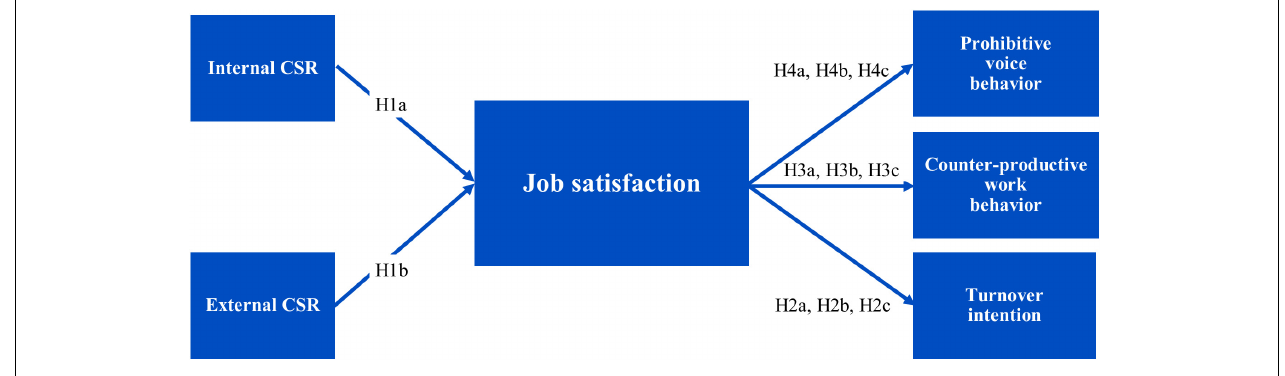
FIGURE 1 | Conceptual model of the relationship between perceived CSR and employee work behaviors through mediation